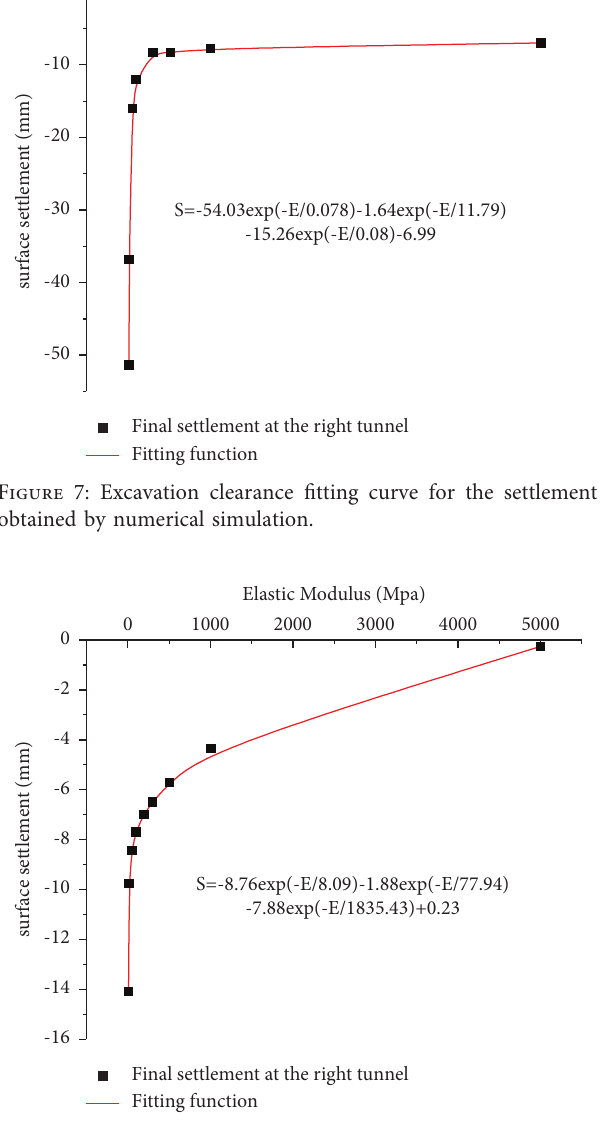
Figure 8: Shield tail clearance fitting curve for the settlement obtained by numerical